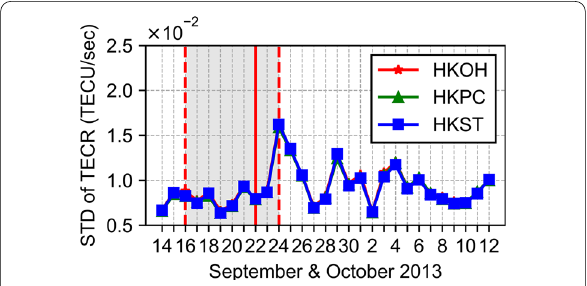
Fig. 9 Daily STD of the TECR (unit: TECU/s) for the HKOH (red line with stars), HKPC (green line with triangles), and HKST (blue line with squares) stations during the period from 14 September to 12 October 2013. The STD of TECR is calculated from the TECR of all the GPS satellites in a particular day. The life cycle of the Usagi was from 16 to 24 September 2013, as represented by the gray background area between two vertical red dashed lines. The vertical red solid line denotes the TC’s landfall near Hong Kong on 22 September 2013